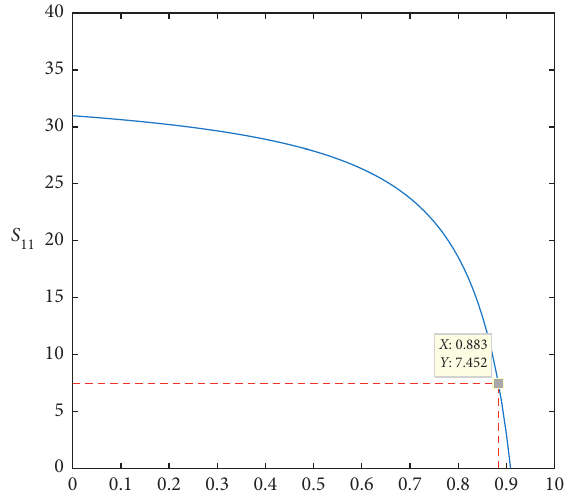
Figure 18: The relationship between pollution stock and ecological compensation